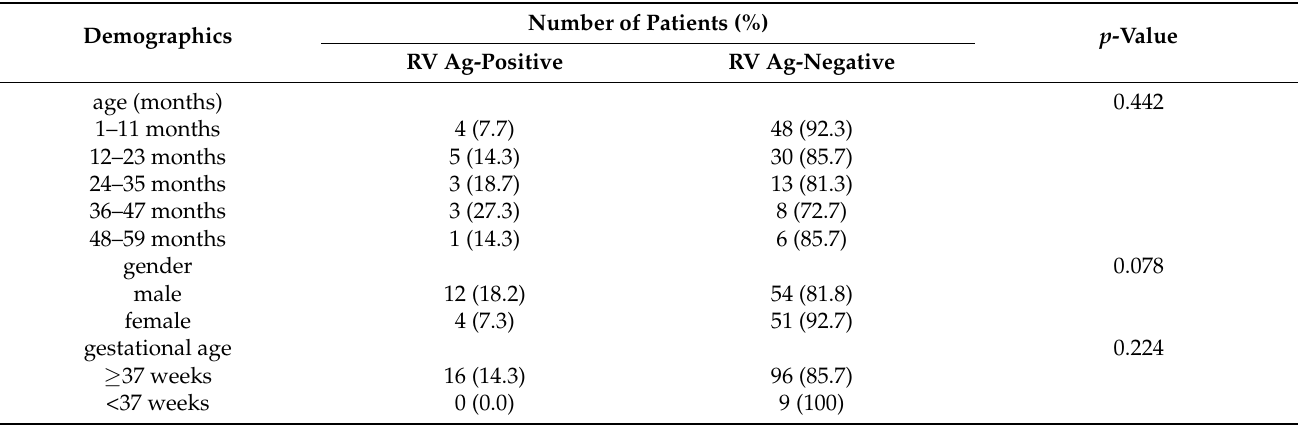
Table 1. Demographic characteristics of rotavirus positive children ( n = 16) and negative children ( n = 105) with hospitalization by acute